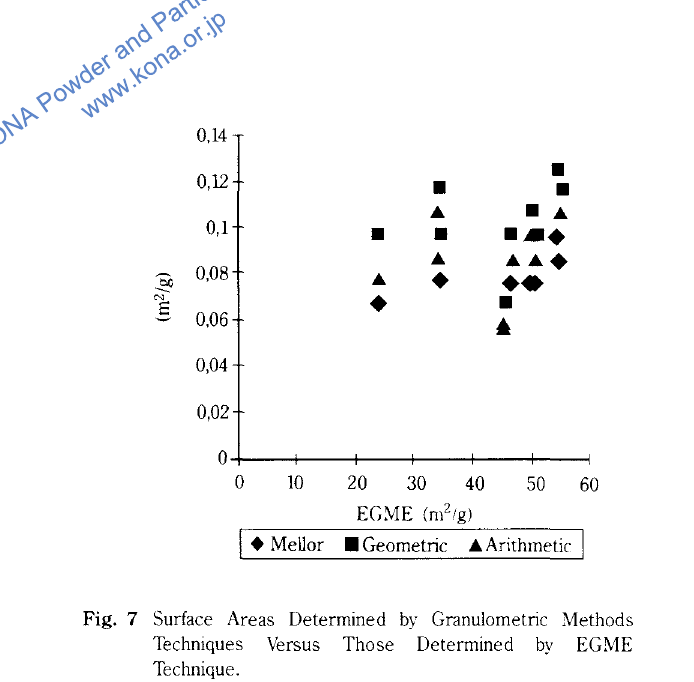
Fig. 7 Surface Areas Determined by Granulometric Methods Techniques Versus Those Determined by EGME